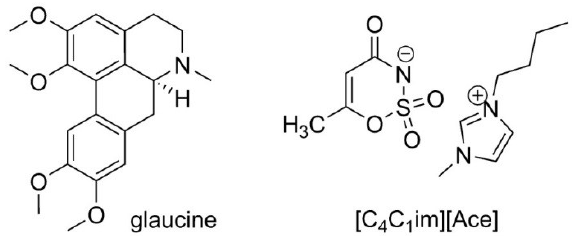
Figure 1. Structures of glaucine and [C 4 C 1